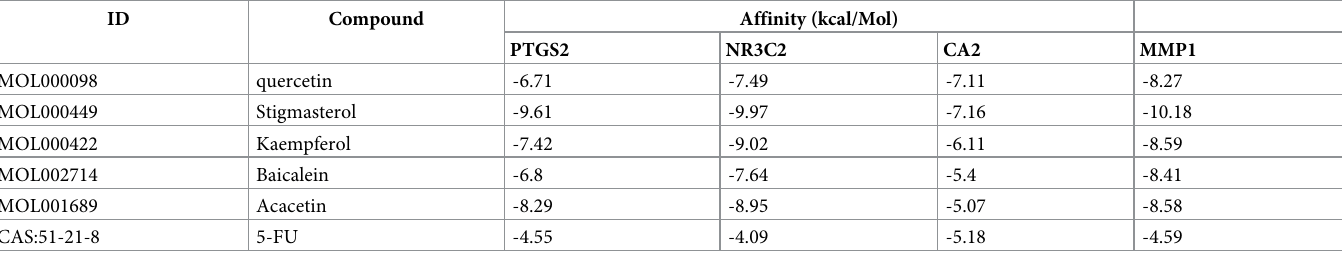
Table 2. The docking affinity and interactions of compounds binding to key targets. ID